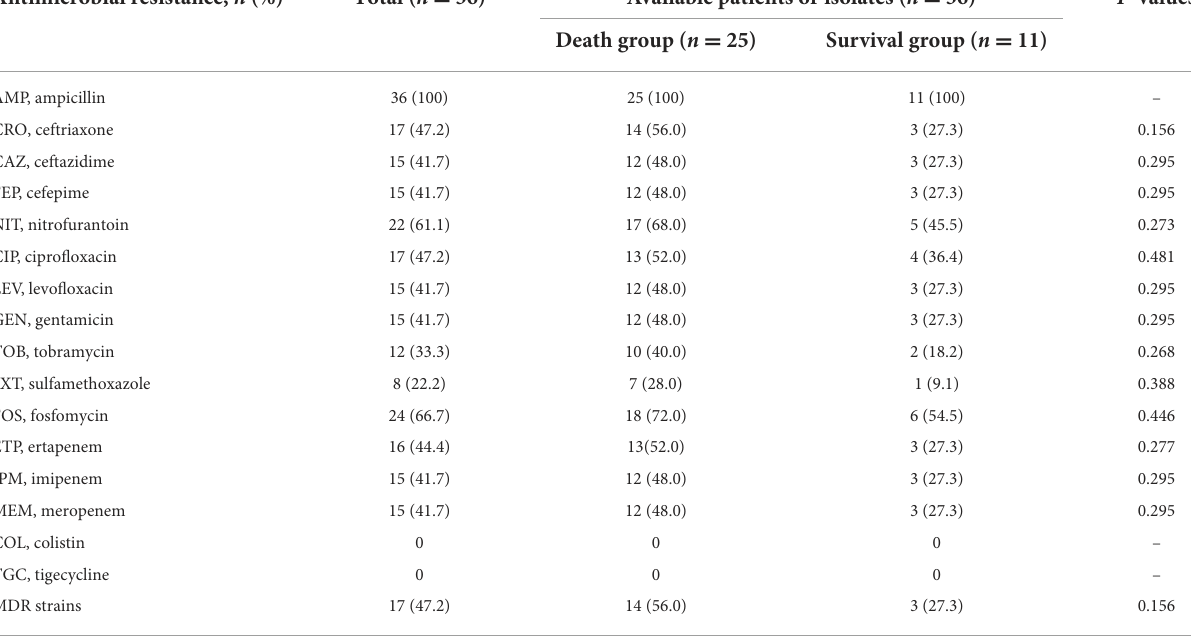
Death group ( n = 25)